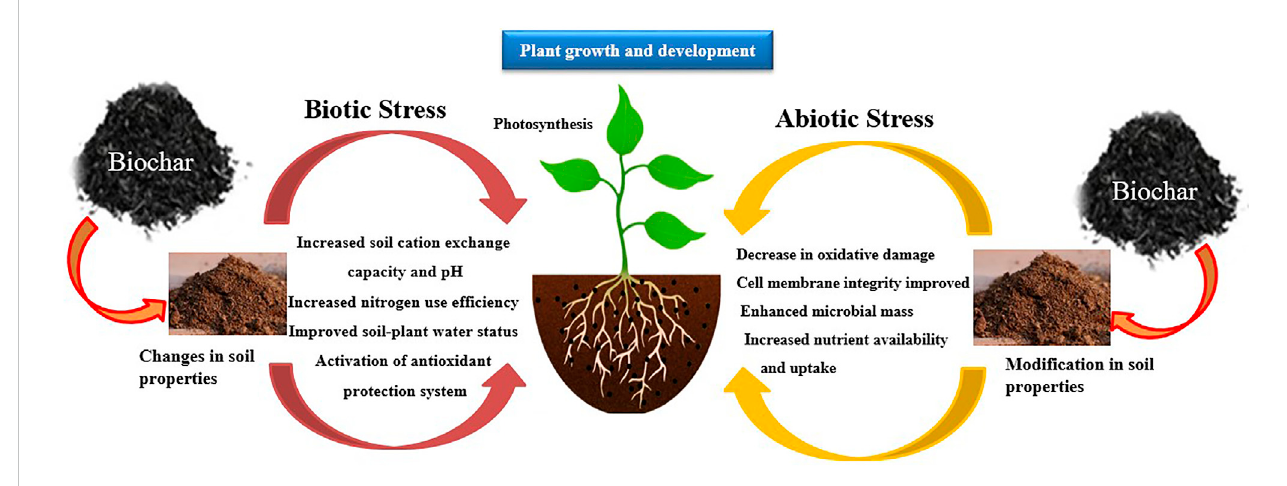
FIGURE 3 Improvement in plant resilience against biotic and abiotic stresses through biochar